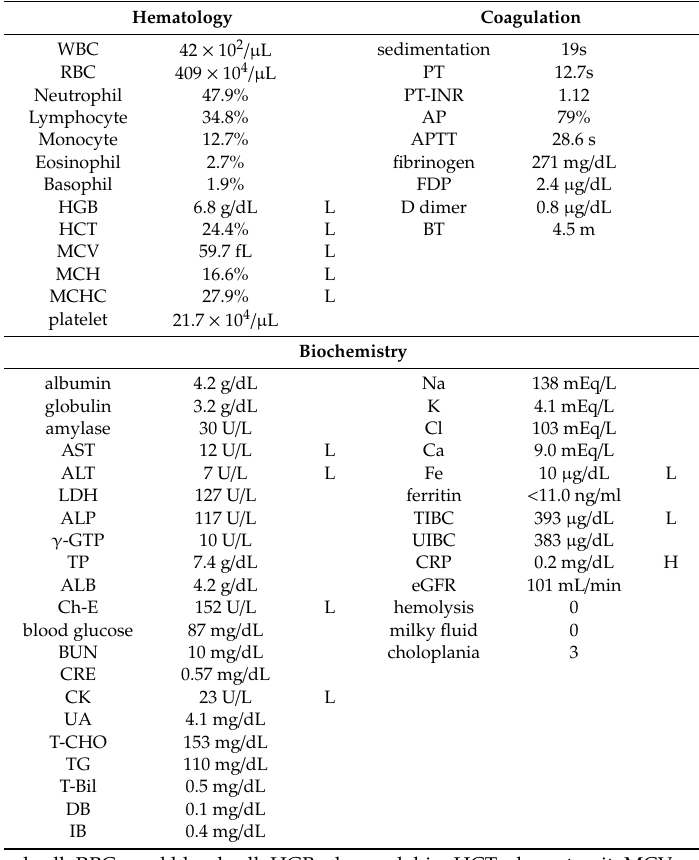
Table 1. Hermansky-Pudlak syndrome (HPS) type 5 patient data obtained at 33 years of age. Hematology